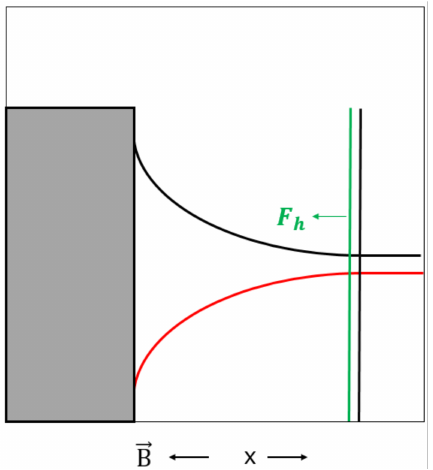
Figure 7. Illustration of concentration profile (black) and reluctance profile (red) in the diffusion layer. F h (green) represents the magnetic concentration gradient force. The magnetic field, perpendicular to the electrode surface. Positive x -direction is